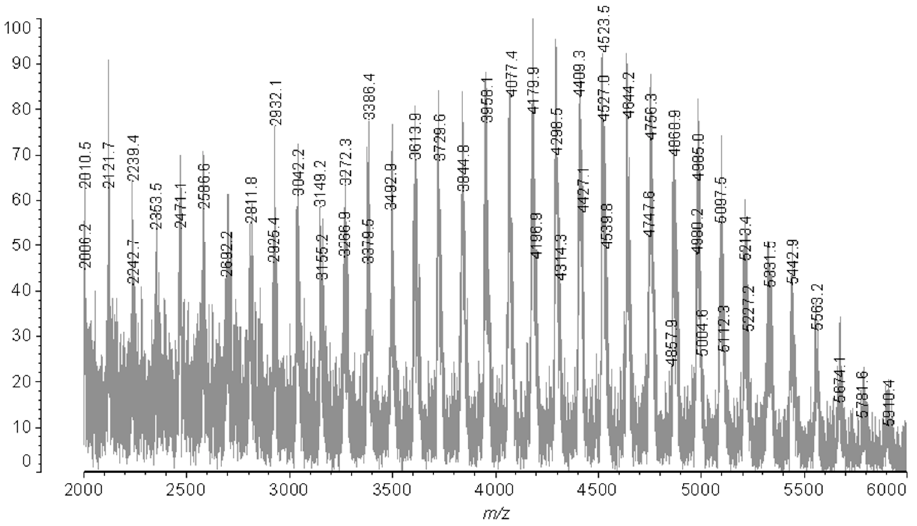
Figure 13. MALDI-TOF spectrum of PIPGE/PAGE/PIPGE-diol (19).